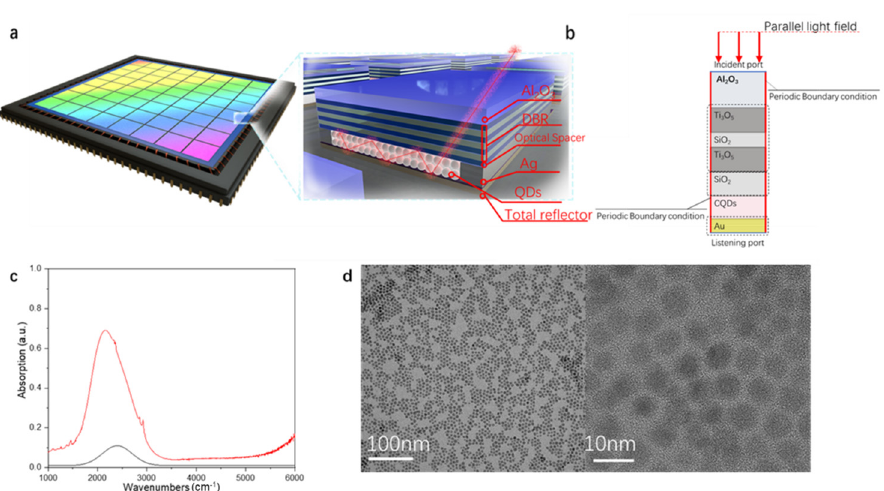
Figure 1. Architecture of the HgSe CQD microspectrometer. ( a ) Schematic of the CQD microspec- trometer, consisting of a CQD sensor and filters. The optical spacer layer is under the DBR, and the quantum dot layer is sandwiched between the optical spacer layer and the optical reflection layer. ( b ) Simulation model of a CQD microspectrometer with a resonant cavity. ( c ) Spectral absorption plots of HgSe CQDs (red line), simulated spectral absorption plots (black lines). ( d ) TEM of HgSe CQDs.